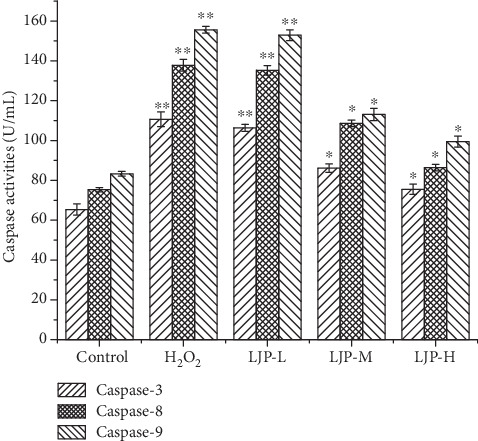
Effect of LJP on the activity of caspase-3, caspase-8, and caspase-9 in cardiomyocytes. Cardiomyocytes were digested, lysed, and then, incubated on ice for 30 min. After incubation, the activity of caspase-3, caspase-8, and caspase-9 in cardiomyocytes was determined. The results are expressed as mean ± SD (n = 10). Statistical significance was determined by One-Way Analysis (ANOVA). ∗P < 0.05, ∗∗P < 0.01 versus control groups.